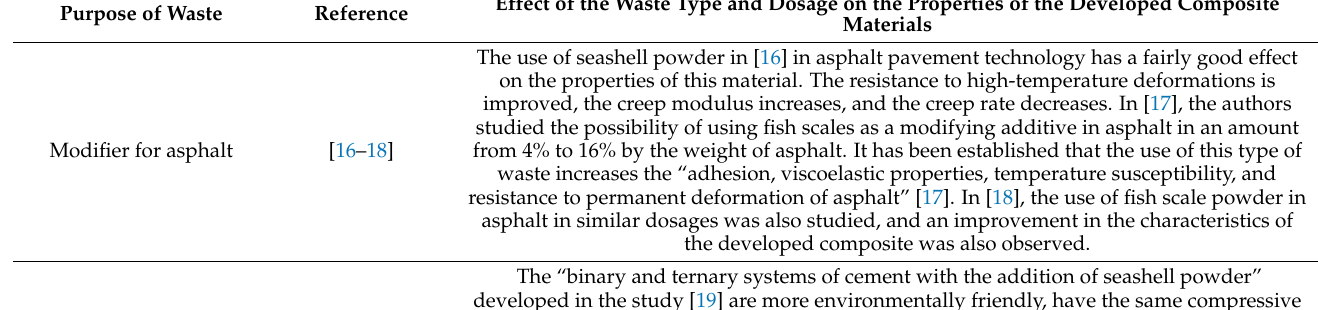
Table 1. Review of the use of aquaculture modifiers in the manufacture of building composite